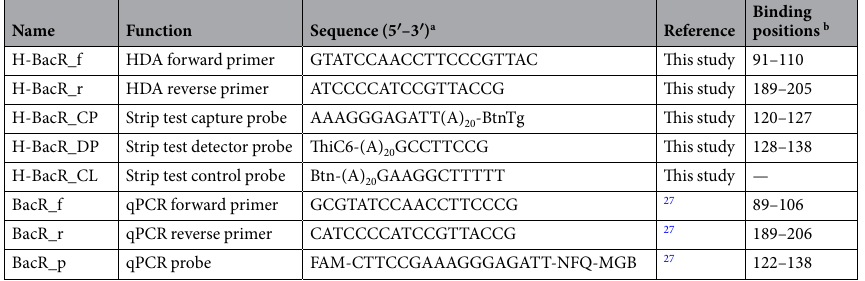
Table 3. Oligonucleotides used in this study. a Abbreviations: FAM, 6-carboxyfluorescein; NFQ, non-fluorescent quencher; MGB, minor groove binder; Btn/BtnTg, Biotin; ThiC6, Thiol group. (A) 20 is a sequence of 20 oligo(dA) used as a spacer. b Binding positions refer to GenBank accession number